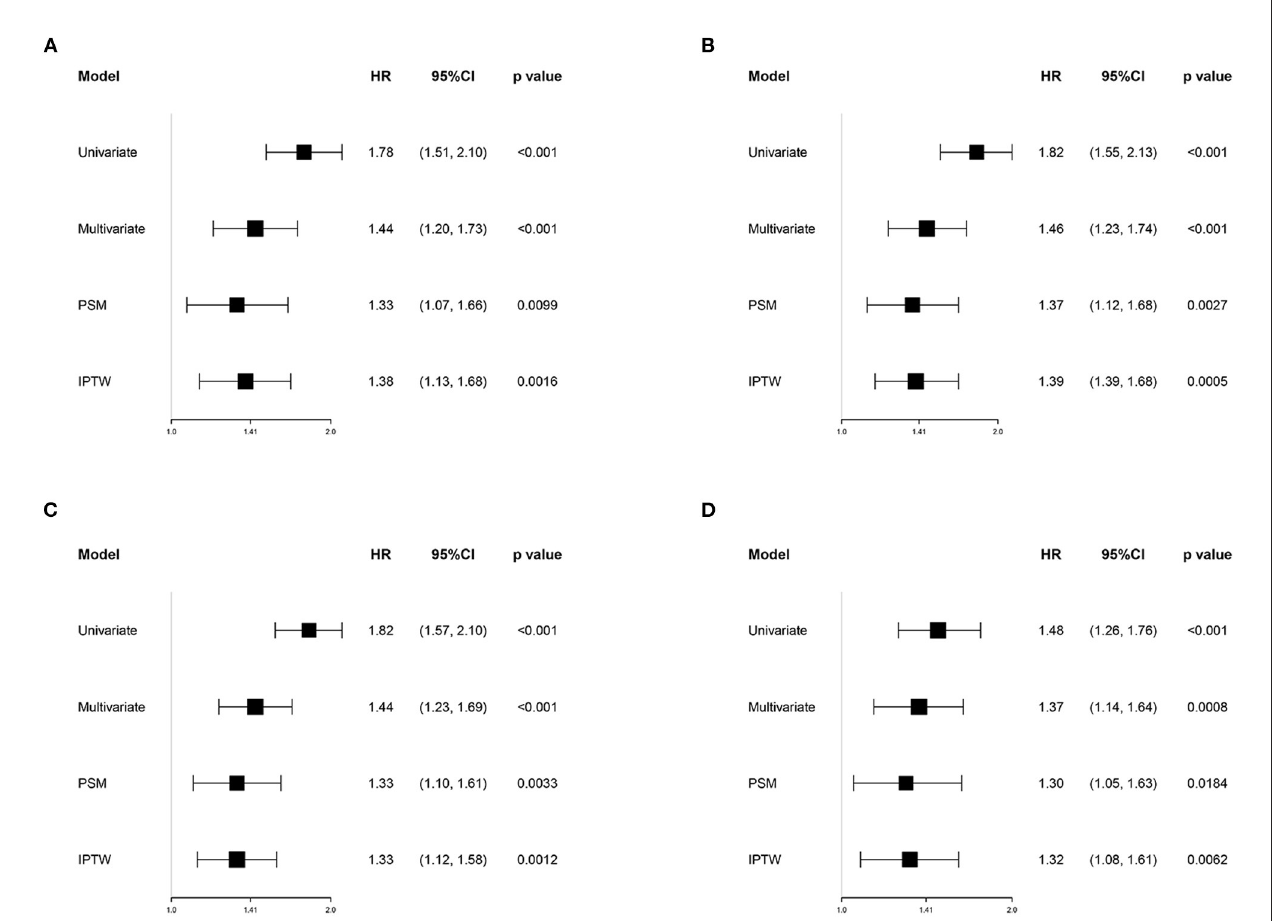
FIGURE4 Association between INR group and 30-day (A) , 90-day (B) , 1-year (C) , and in-hospital (D) all-cause mortalities in different models. Univariate model was adjusted for none. Multivariate model was adjusted for age, gender, race, type of ICU for the first time, SOFA, SAPSII, Charlson comorbidity index, heart rate, mean blood pressure, anion gap, serum urea nitrogen, mechanical ventilation, vasopressors, renal replacement therapy, aspirin, warfarin, heparin, and the transfusion of fresh frozen plasma and platelets. HR, hazard ratio; CI, confidence interval; PSM, propensity score matching; IPTW, inverse probability of treatment weighting; SOFA, the sequential organ failure assessment; SAPSII, the simplified acute physiology score